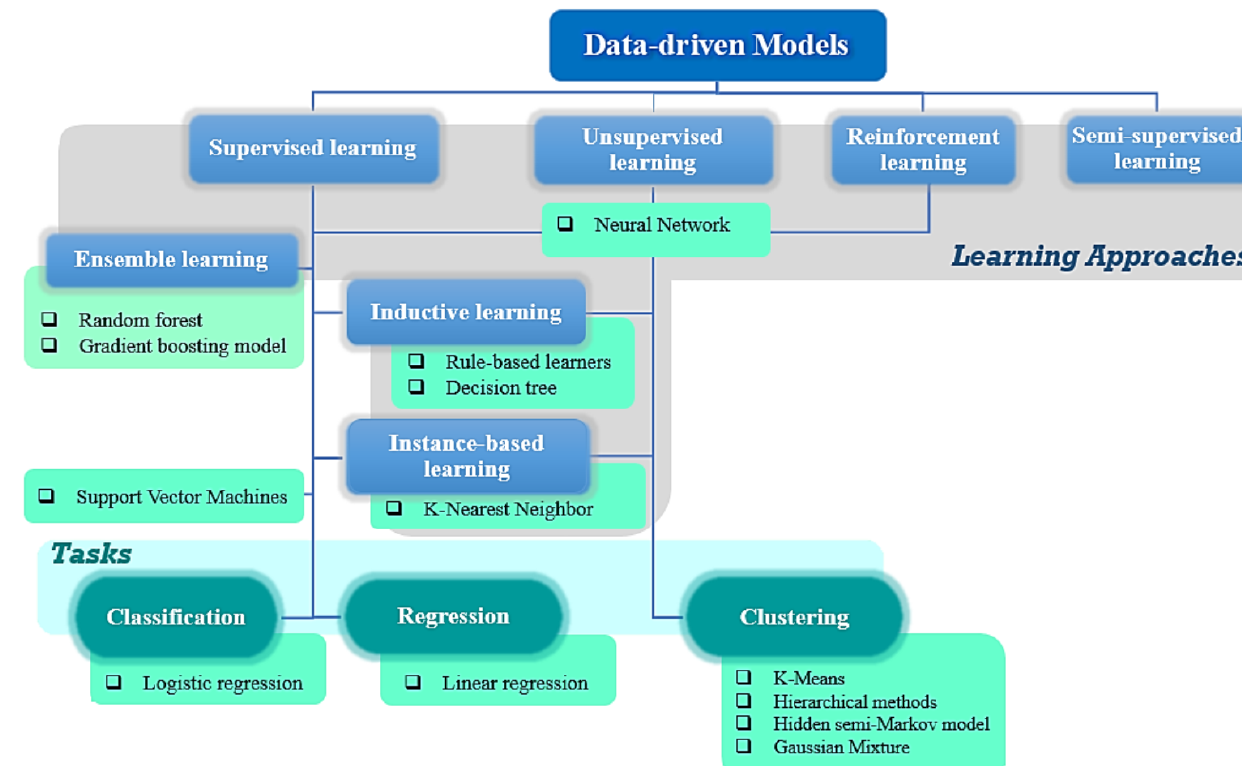
Figure 3. Classification of machine learning approaches, methods, and tasks (learning approaches (grey blocks) and learning modes (light green blocks)).